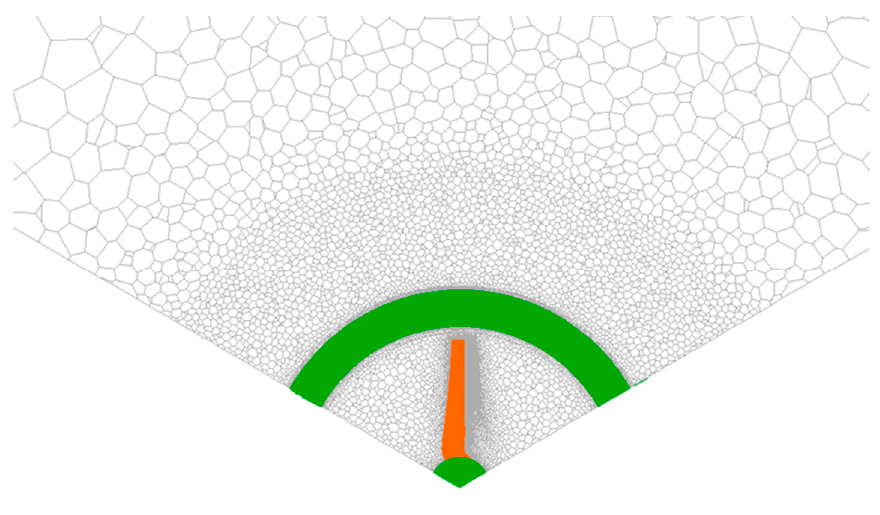
Figure 8. Mesh cut at turbine